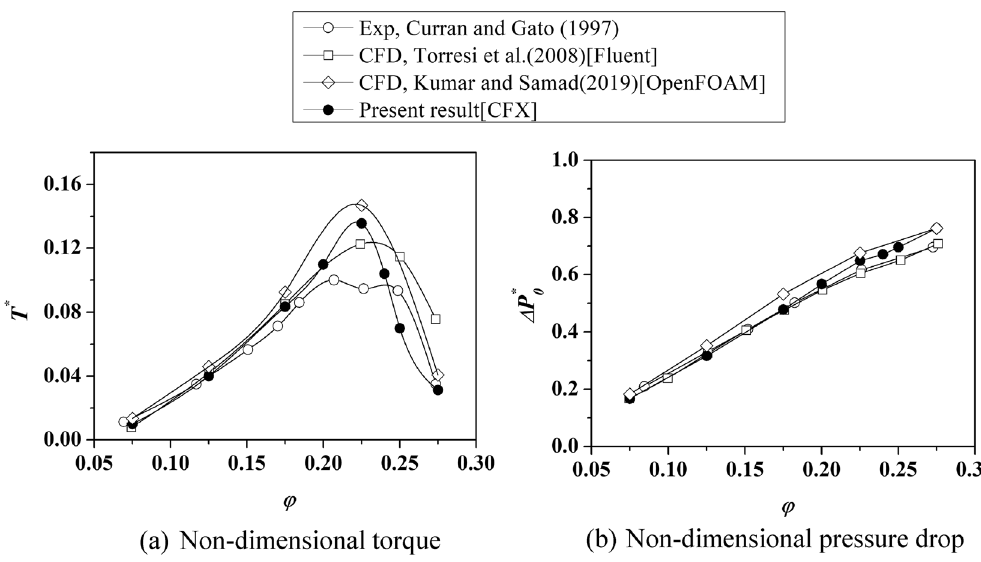
Figure 7. Numerical model validation using existing data.